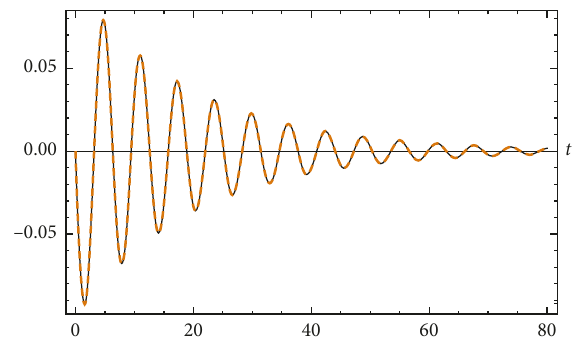
Figure 9: Comparison between the approximate analytical solution and the numerical solution for Example